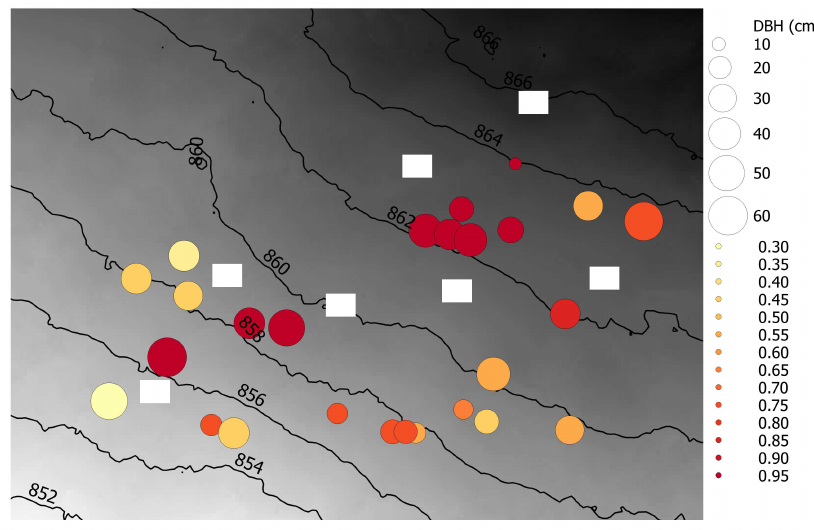
Figure 2. The area of the study site approximately equals 31 m × 16 m. Seven scan locations are marked by white rectangles. Tree positions are marked by solid circles. The size is scaled by the DBH, and color is scaled by the percentage of TLS coverage (i.e., 0–1 (100%)). Contours are derived from the DTM.